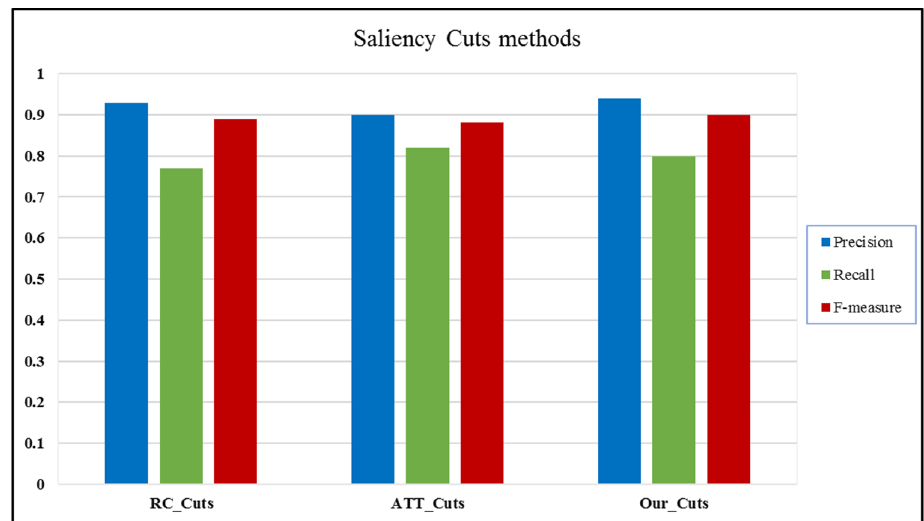
Figure 12. Quantitative comparisons of saliency cuts approach using MSRA 10k dataset. Table 1. Quantitative analysis of three saliency cuts methods performed using MSRA 10k